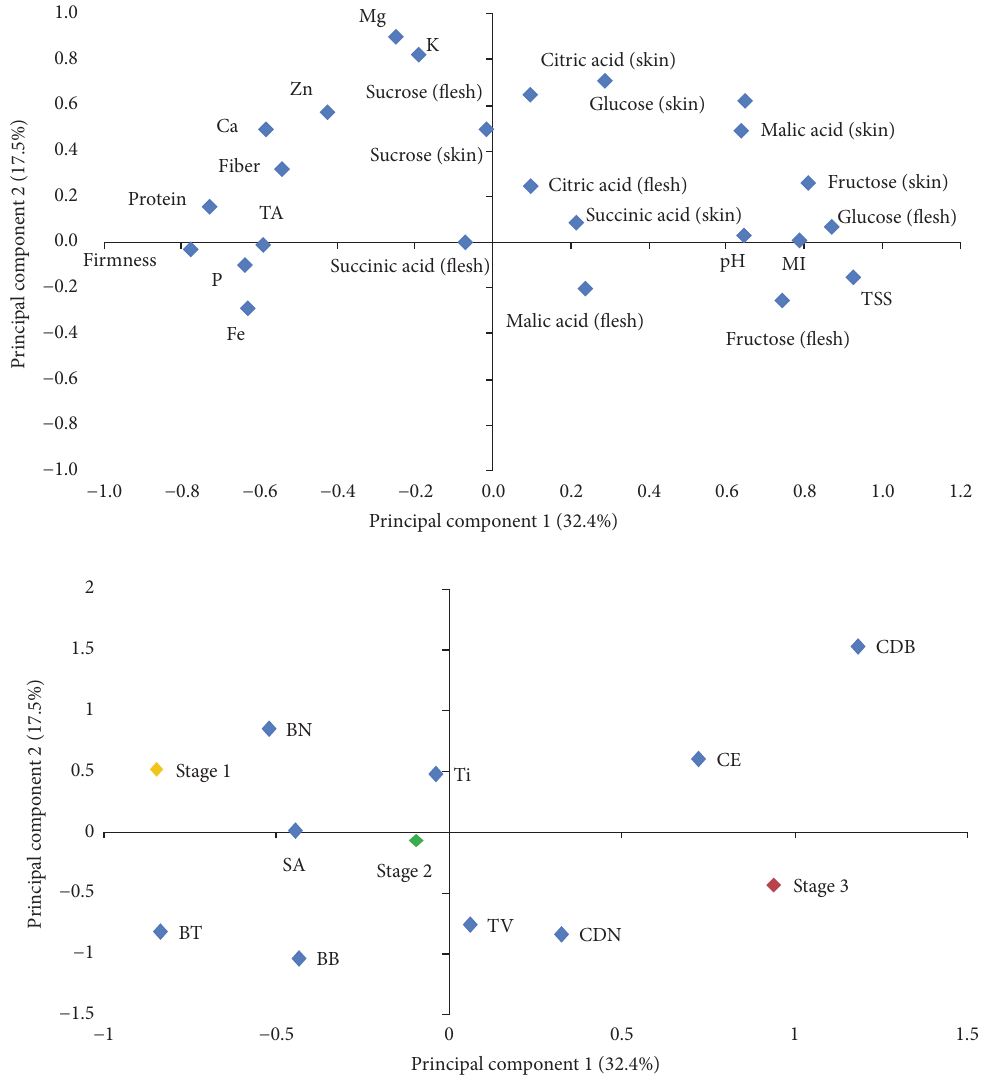
Figure 3: Loading plot and score plot after principal component analysis of the variables and individuals in the plane by two first principal components (PC1 and PC2). CDB: Cuello Dama Blanco; BT: Brown Turkey; Ti: Tiberio; SA: San Antonio; CDN: Cuello Dama Negro; BN: Banane; CE: Colar Elche; TV: Tres Voltas L’Any; BB: Blanca B´etera; TA: Titrable Acidity; TSS: Total Soluble Solids; MI: Maturation Index.